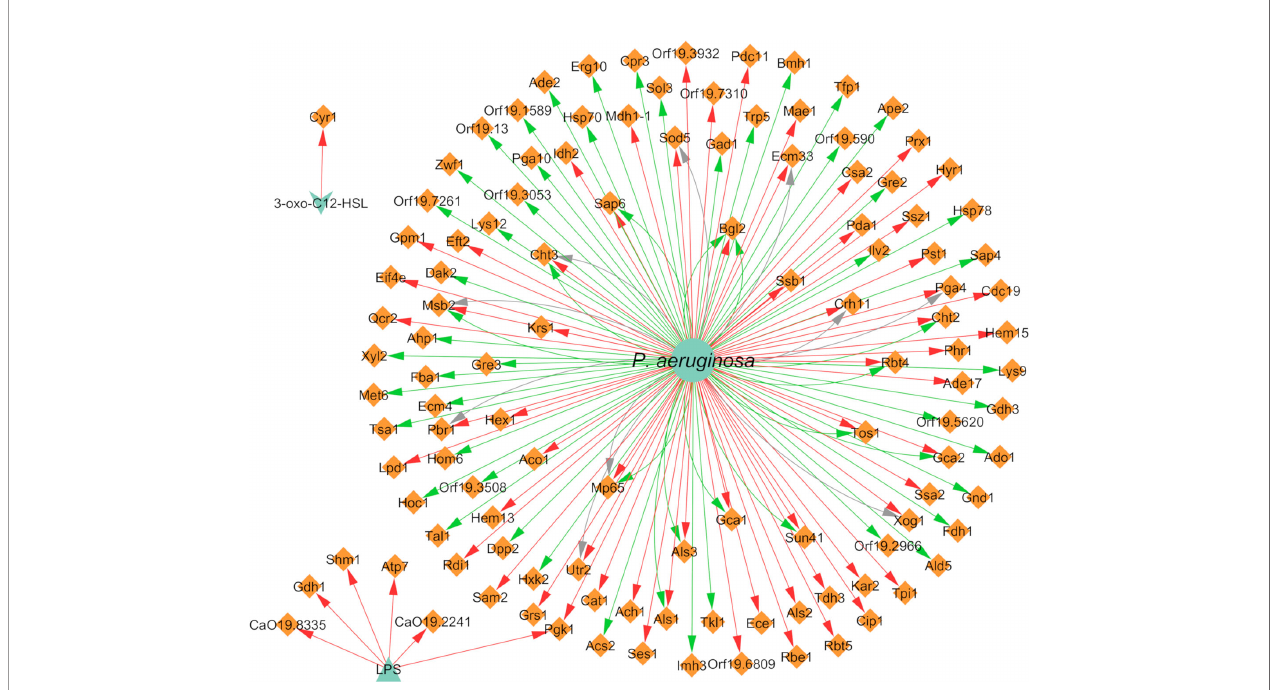
FIGURE 7 | Network of the effects of P. aeruginosa on C. albicans protein expression. Legend: Teal nodes, P. aeruginosa ; orange nodes, C. albicans ; green arrows, upregulation; grey arrows, null effect; red arrows: downregulation; node and node label sizes are directly proportional to the number of related (outward and inward) edges (interactions).